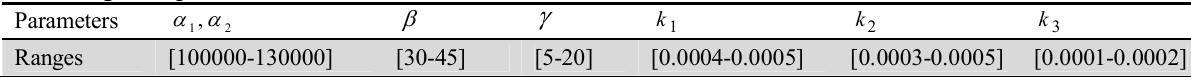
Table 4 and Table 6 show Nash equilibrium, Manufacturer-Stackelberg Equilibrium and cooperative equilibrium solutions.